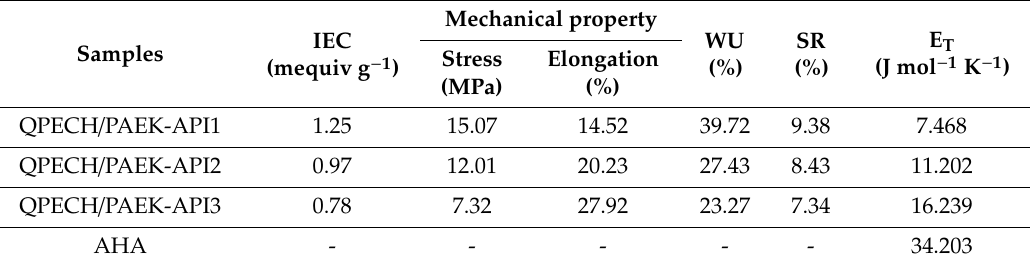
Table 1. IEC, water uptake, length swelling percentage and mechanical properties of QPECH/PAEK- API membrane.